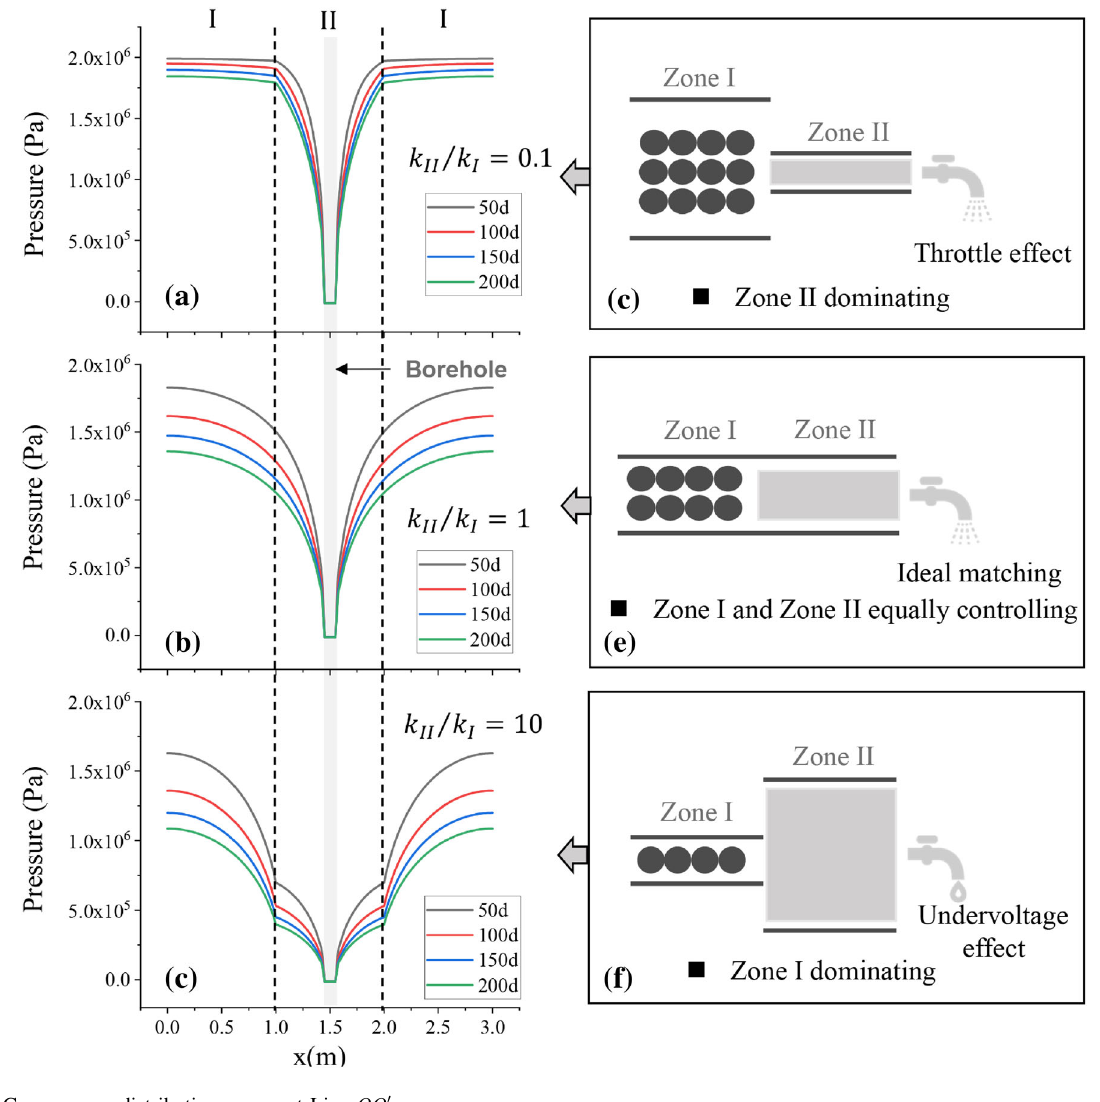
Fig. 5 Gas pressure distribution curves at Line OO